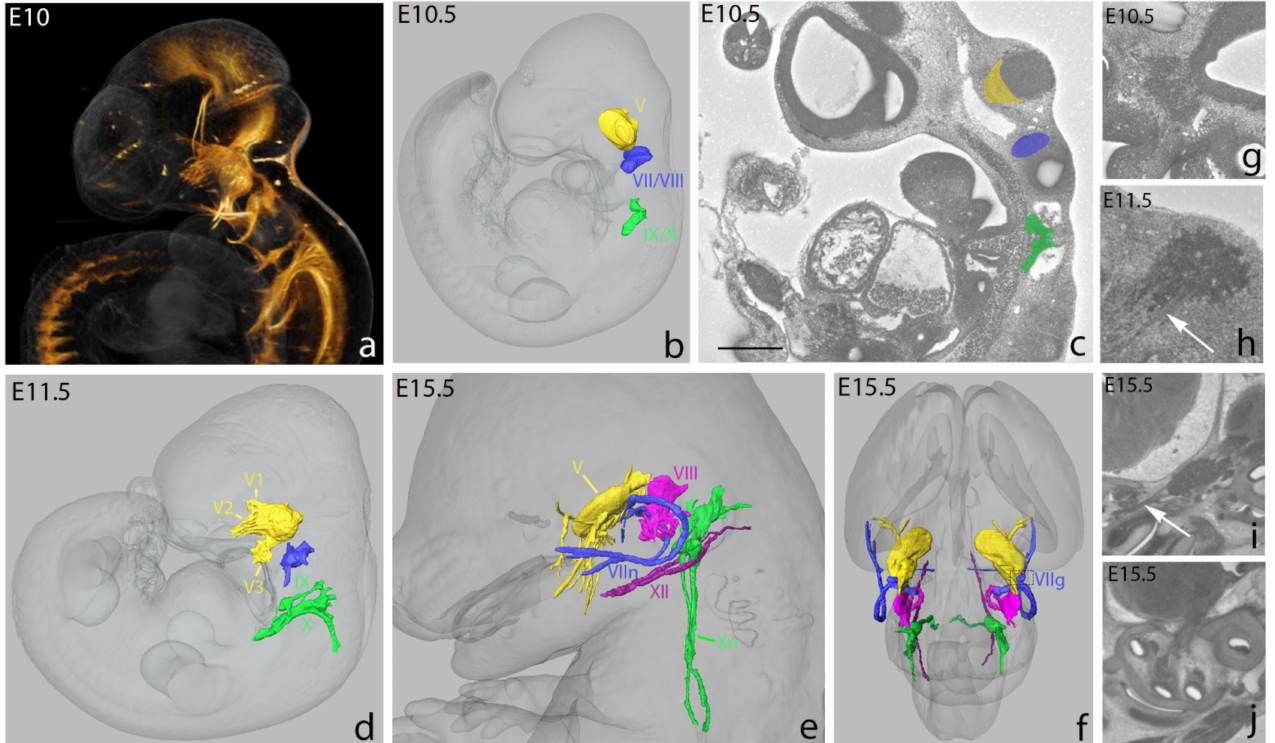
Figure 3. 3D representation of cranial nerves and ganglia at E10, E10.5, E11.5 and E15.5. Whole-mount immunostaining of an E10.0 embryo with an antineurofilament antibody ( a ). 3D reconstruction of the ganglia at E10.5 ( b ), the ganglia and cranial nerves at E11.5 ( d ) and E15.5 ( e , f ). The whole embryo, head and brain are represented in shades of gray. Segmentation of ganglia at E10.5 on HREM 2D data ( c ). Visualization of trigeminal ganglion (V) at E10.5 ( g ), trigeminal ganglion and nerves (white arrow) at E11.5 ( h ) and E15.5 ( i ). Note the absence of visible nerve fibers at E10.5 compared to E11.5 (red arrow). Visualization of vestibulocochlear ganglia and nerves (VIII) on 2D data ( j ): note the difficulty of segmenting ganglia and nerves at these developmental stages. V: trigeminal ganglion, V1, V2, V3: ophthalmic (V1), maxillary (V2) and mandibular (V3) branches of the trigeminal nerve, VII/VIII: facioacoustic ganglion complex, VII: facial ganglion, IX/X: glossopharyngeal and vagus ganglion complex, IX: glossopharyngeal ganglion, X: vagus ganglion, Xn: vagus nerve, XII: hypoglossal nerve. Scale bar in ( c ): 350 µ m, ( g ): 350 µ m, ( h ): 200 µ m, ( i ): 900 µ m, ( j ): 600 µ